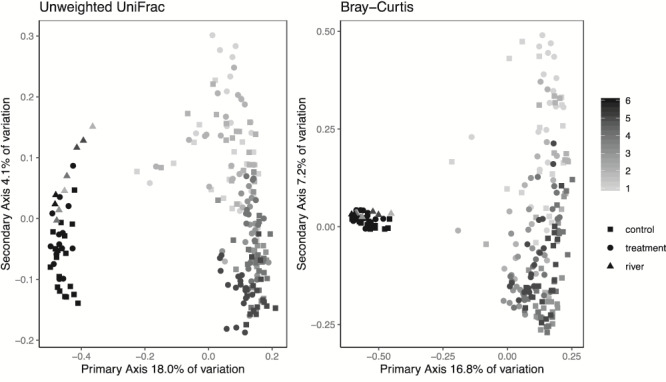
PCoA plots depicting beta diversity comparisons of microbiota on the skin of treatment and control hellbenders (Cryptobranchus a. alleganiensis) and river water over the 6-week experimental period. The color gradient is indicative of experimental week, with Week 1 being depicted as light gray and Week 6 being depicted as black. Square points indicate control individuals, circular points are used for treatment individuals and triangular points correspond to Blue River water samples. We have presented unweighed UniFrac and Bray–Curtis methods, both of which show a distinct separation in beta diversity at Week 6 compared to Weeks 1–5, regardless of group and overlap in composition between hellbender skin at Week 6 and all river water samples